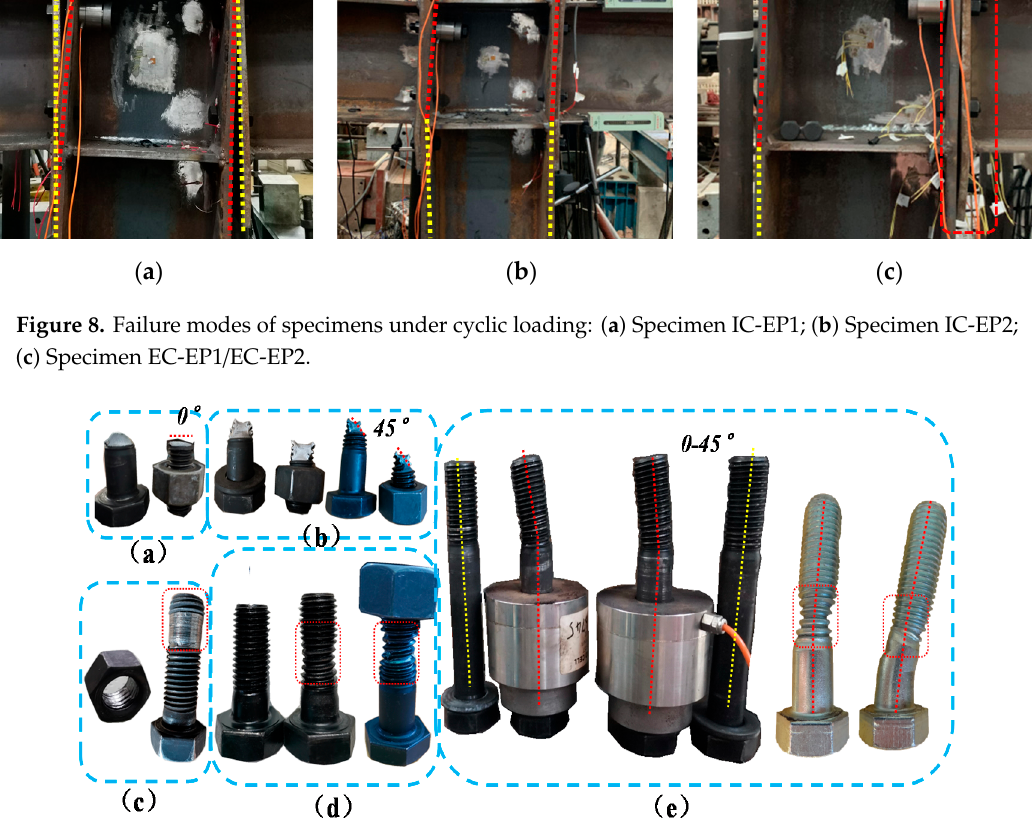
Figure 10. Local deformation of specimens: ( a ) Weld fracture; ( b ) Upper flange end-plate bending; ( c ) Lower flange end-plate bending; ( d ) Separation of end-plate and column web.